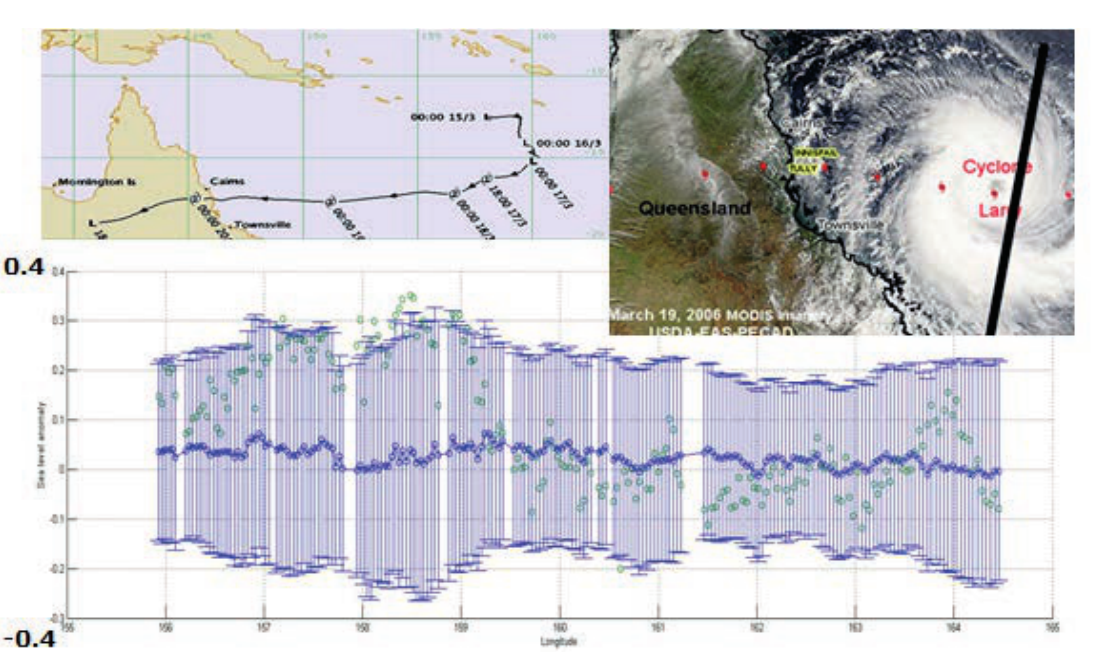
Fig. 4 The tropical cyclone Larry that hit the Queensland coast in March 2006. The upper left figure shows the path, category of Larry and the dates of the cyclone. The upper right picture is a MODIS image from 19 March 2006 with the Jason-2 track. The lower left picture shows the retracked sea surface height along the track shown in Fig. 5. The mean sea level anomalies (SLAs) around zero are shown in solid blue circles. The 2 times standard deviations are shown in blue bars. The observed SLAs during the cyclone Larry are shown in green circles (values are given in